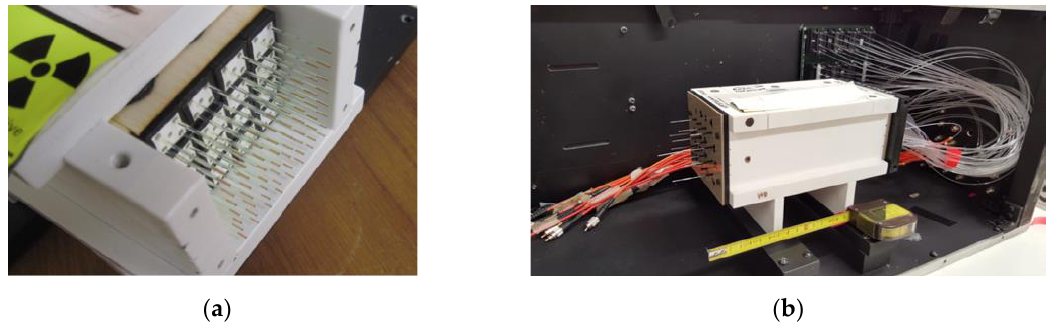
Figure 3. ( a ) The 4 × 4 modular array during assembly. ( b ) Fiber optic waveguides used to transmit the WLS light to SiPM photosensors positioned outside of the beam region for this specific test. In the picture, the incoming electron beam is incident from the left on the 4 × 4 modular array enclosed within the white mechanical housing.